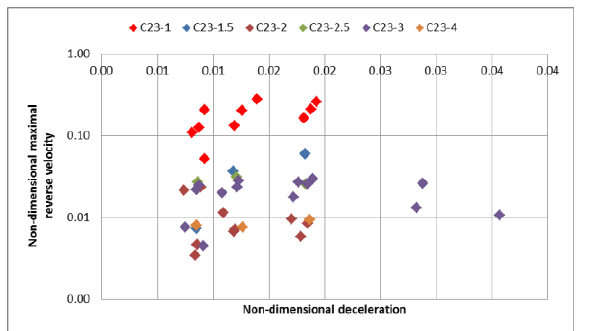
Fig. 20. Dynamic property of the C23 combined valve